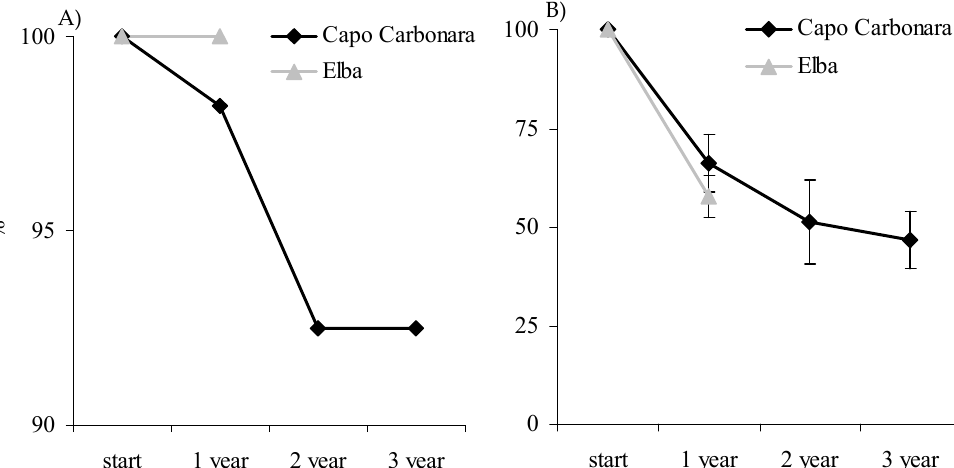
Figure 10. Percentage of plots remained in situ ( A ) and mean ( ± SE) survival of cuttings ( B ) in Capo Carbonara and Elba Figure 10 . Percentage of plots remained in situ ( A ) and mean (± SE) survival of cuttings ( B ) in Capo Carbonara and Elba efforts every year to efforts every year to date. Table 1. PERMANOVA results on the survival of cuttings of the two restoration efforts after one year to start.